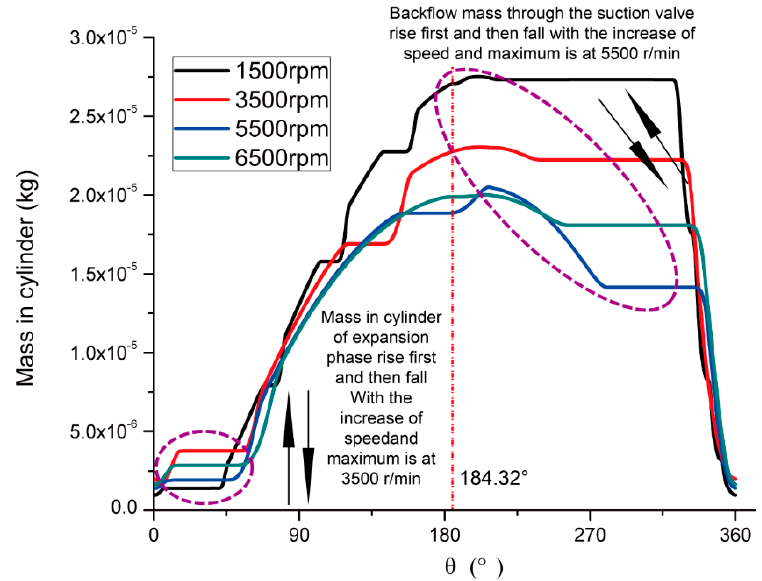
Figure 13. The m- θ diagram under different rotating speed.